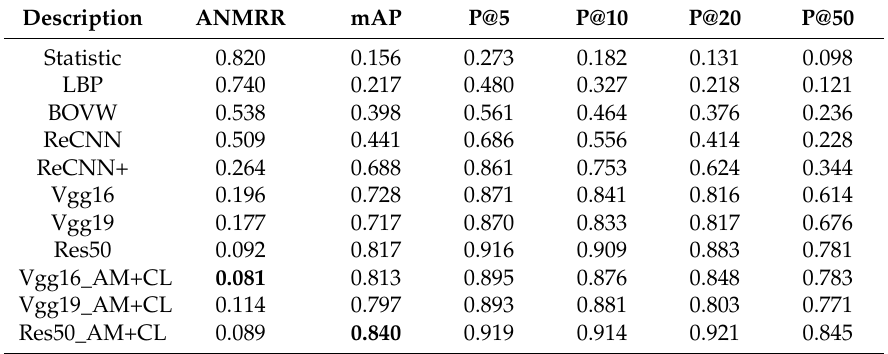
Table 7. Comparisons between our methods and the baselines. The best result is reported in bold. Description ANMRR